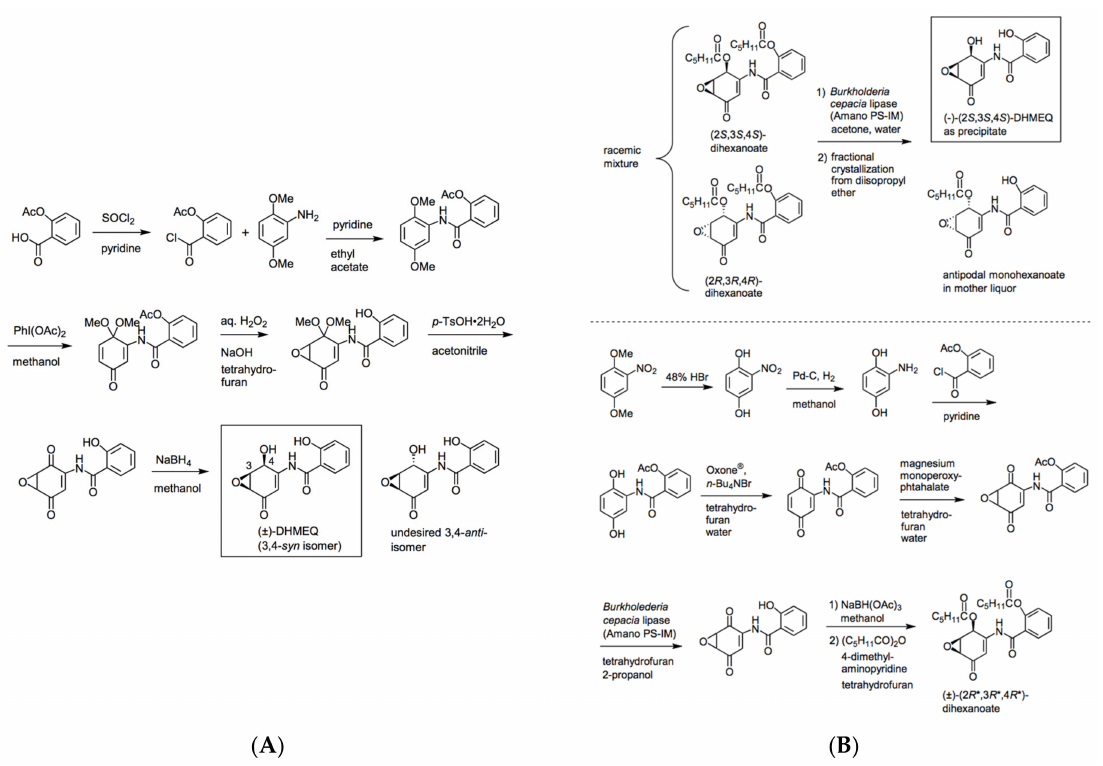
Figure 2. ( A ) Preparation of racemic DHMEQ. ( B ) Chemo-enzymatic synthesis of enantiomerically pure